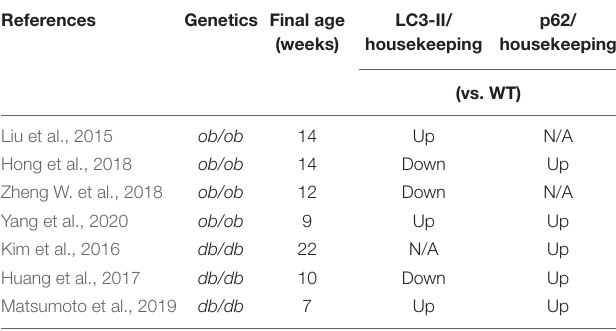
TABLE 3 | Leptin and leptin-receptor deficient